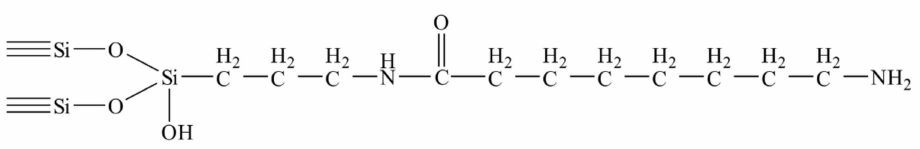
Figure 6. Aerosil with an engrafted